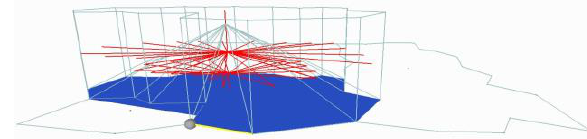
Fig. 12. Example of Point Extrusion technique